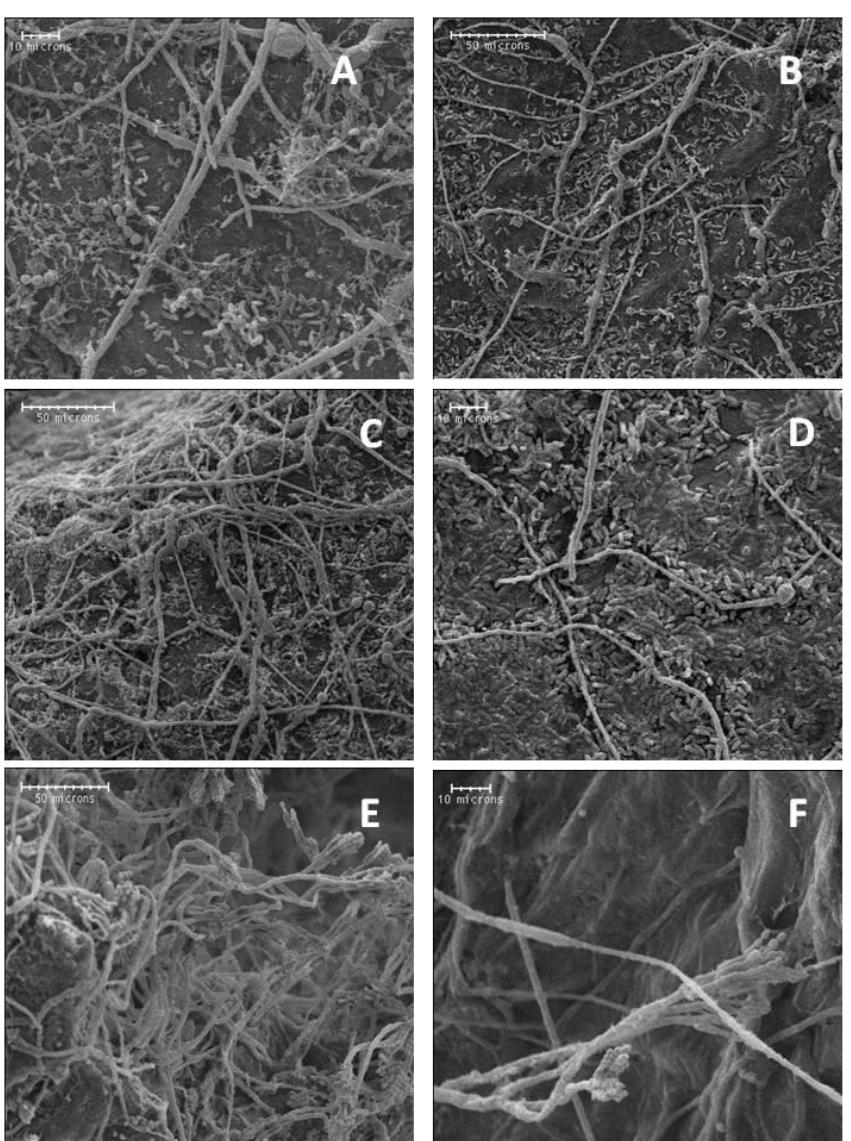
Figure 5. Scanning electron micrographs of biocontrol bacterial cells interacting with hyphae of P. expansum in apple wounds four days after inoculation. ( A , B ) Isolate A3-6 at 500 × and 1000 ×, ( C , D ) isolate A3-2 at 500 × and 1000 ×, and ( E , F ) no-bacteria control at 500 × and 1000